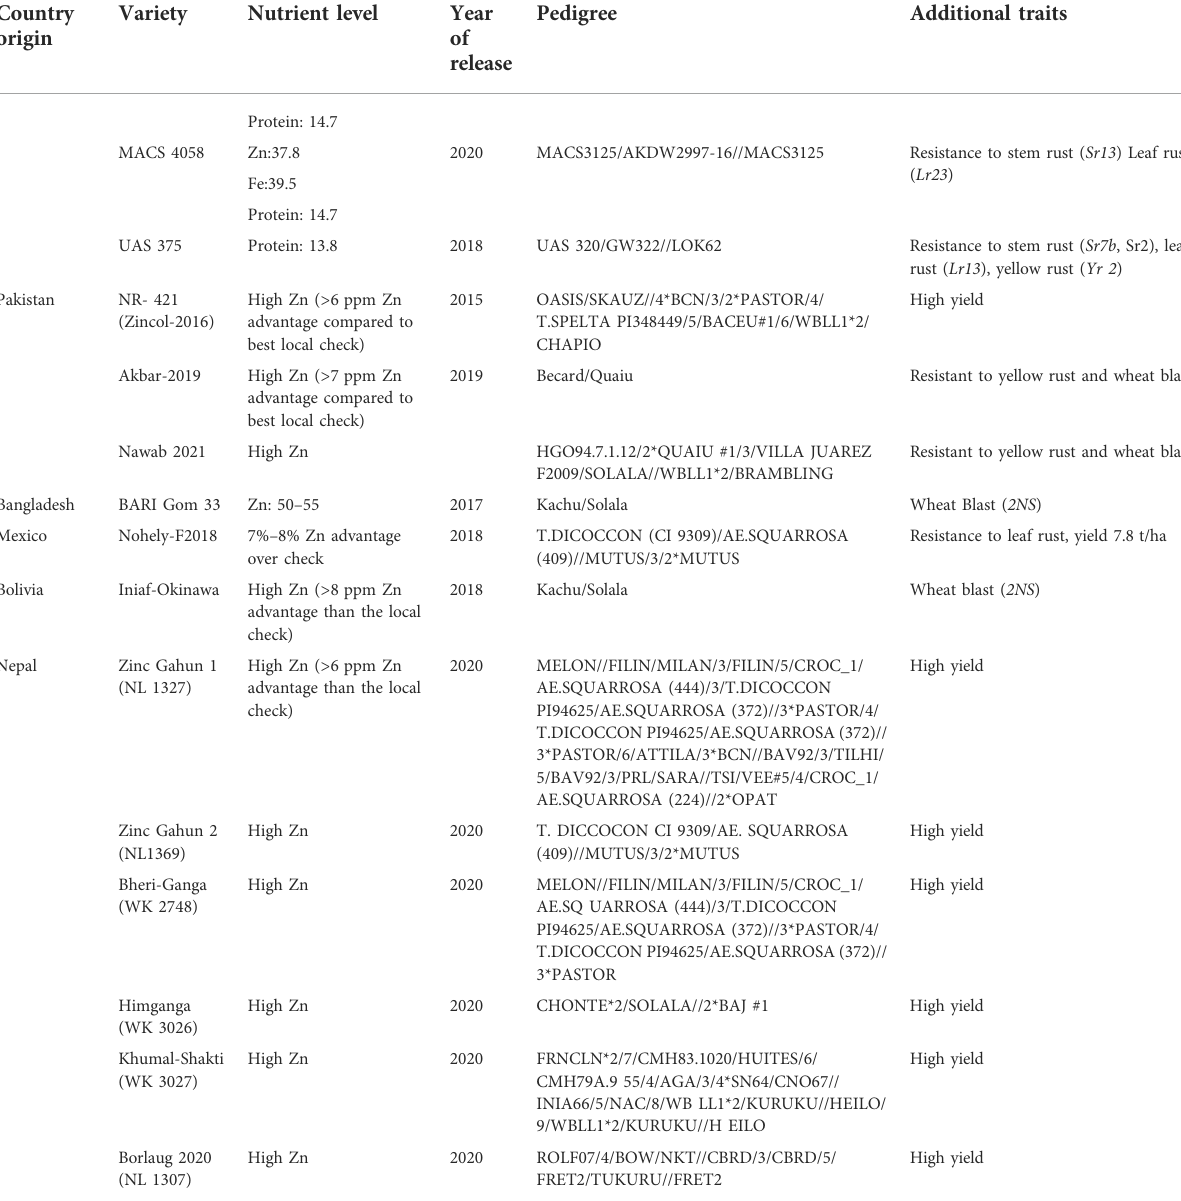
TABLE 3 ( Continued ) List of bioforti fi ed wheat varieties released for commercial cultivation with their grain micronutrient level (ppm), protein content (%) and additional traits (modi fi ed from Gupta et al.,